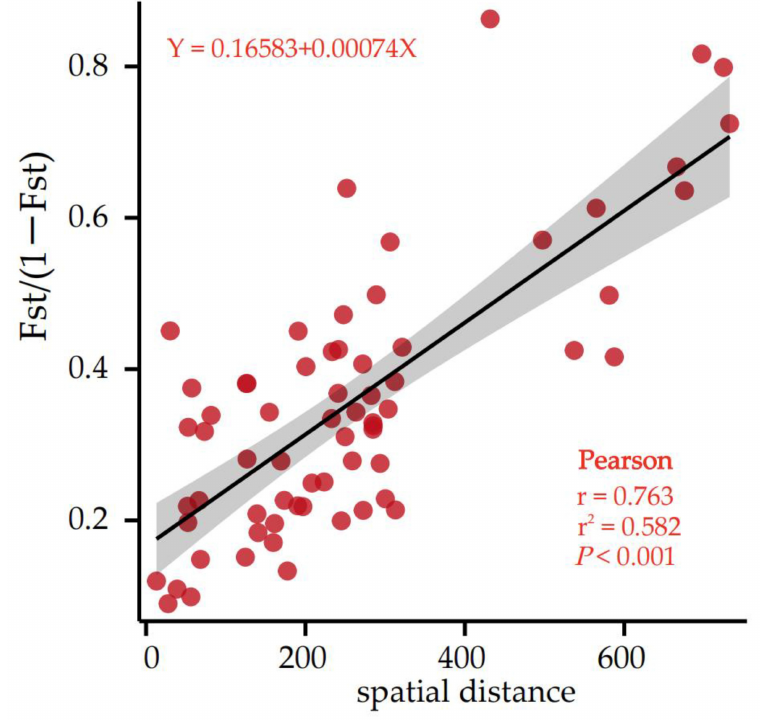
Figure 3. Matrix plot of the Mantel test of genetic differentiation and geographic